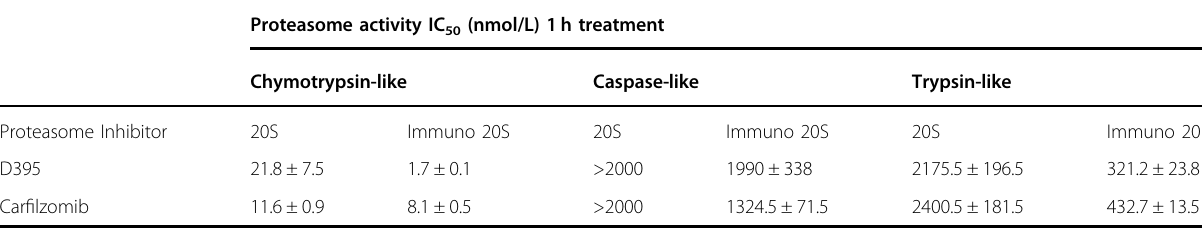
Table 1 The enzyme biochemical activity pro fi les of D395 against the 20S